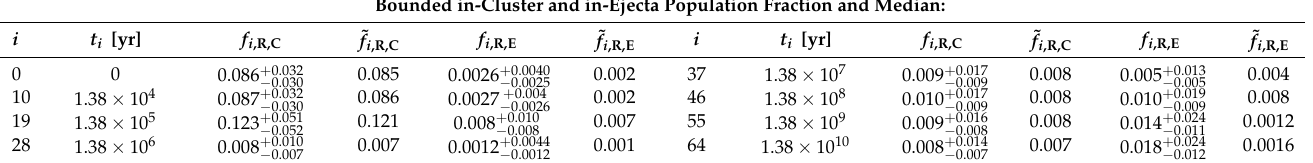
Table 8. Mean bounded in-cluster and in-ejecta object population fractions ˜ f i ,B,P and median ˜ f i ,B,P where P = ( C,E ) . The fraction is centred around the mean and shown are the 95% C.B. and is computed along with the median by averaging over the N R = 5000 realisations at selected